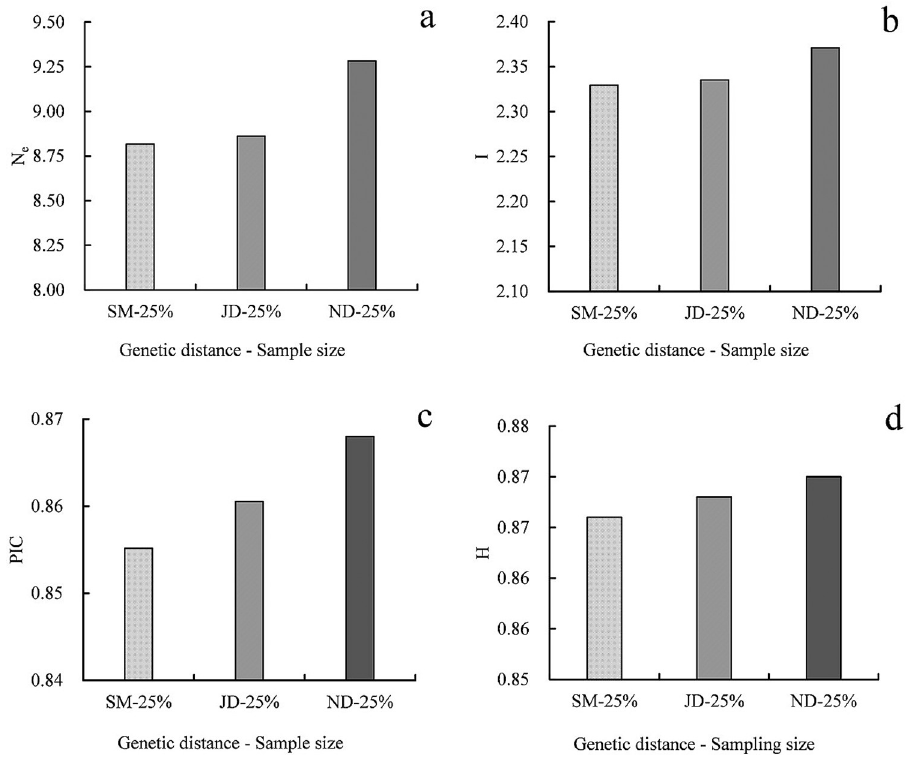
Fig 2. Values of Ne, I, PIC and H of core subsets based on the allele preferred strategy and different genetic distances with a given sample size. N e : Number of effective alleles, I: Shannon’s information index, PIC: Polymorphic information content, H: Nei’s gene diversity, ND: Genetic distance using Nei & Li genetic similarity coefficient, SM: Genetic distance using simple matching coefficient, JD: Genetic distance using Jaccard genetic similarity